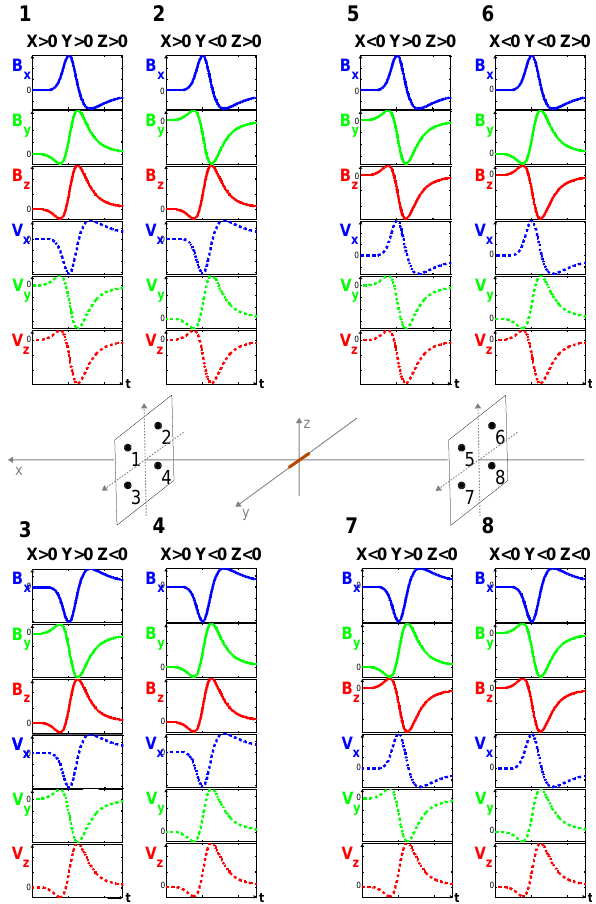
Fig. 2. Schematic map of the characteristic time variations of the magnetic field and plasma velocity in the inflow region. Each plot in each panel presents the variation of corresponding variable around zero level in normalized units depending on time in standard time units. Numbered points denote different possible locations of the ’detector’; x -direction is collinear to the direction of the flow, the y is the direction of the reconnection electric field, z is perpendicular to the current sheet plane.